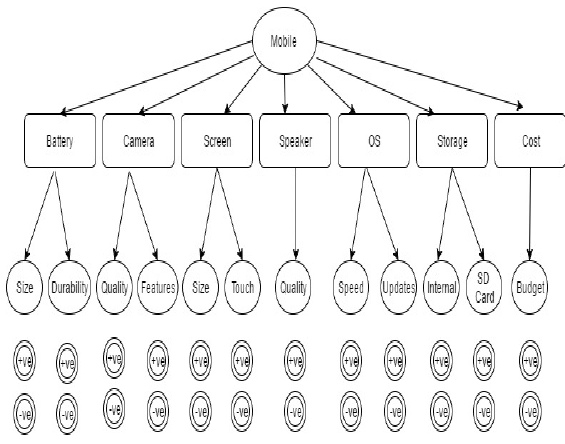
Figure 1 . Tree with subsequent positive and negative polarities of the features of the product